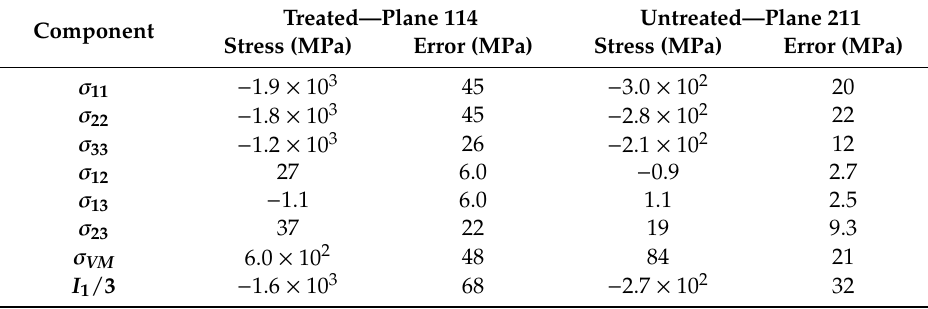
Table 2. Residual stress results